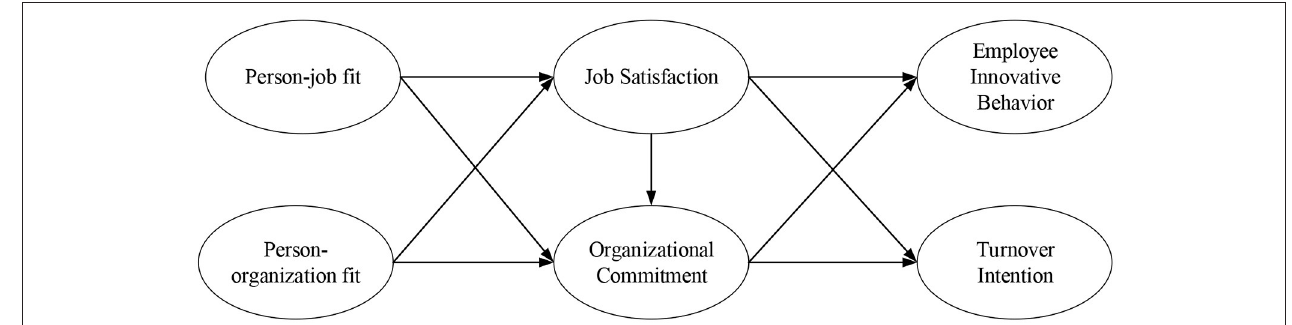
FIGURE 1 | Research model.